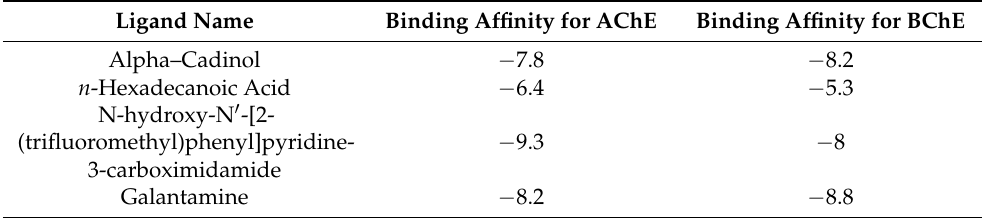
Table 6. Binding affinity of ligands and acetylcholinesterase and butylcholinesterase.